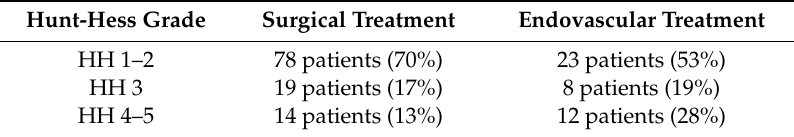
Table 6. The modality of treatment according to Hunt–Hess grade